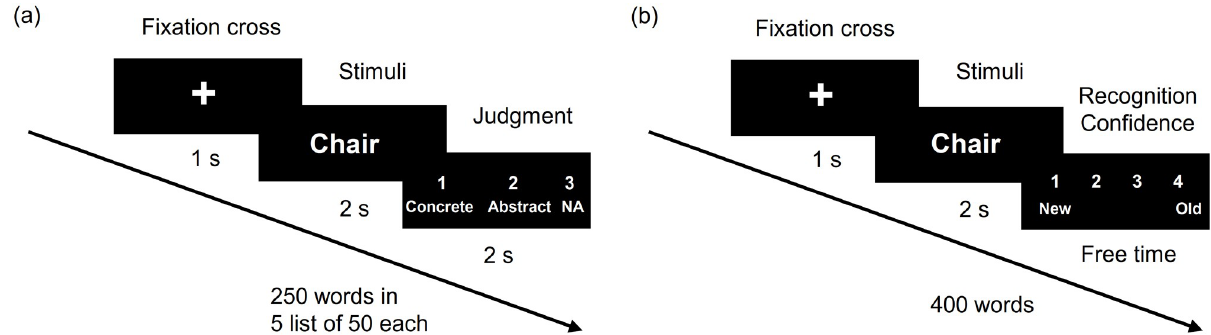
Fig 1. Experimental timeline of the declarative memory paradigm. (a) Encoding task: 250 words are presented in five lists of 50 words each. (b) Retrieval task: 400 words (250 old words and 150 new words) are presented. Participants have to select whether the presented stimulus is an old or new word, depending on the stimulus presented in the encoding task. These two tasks are separated by an arithmetic distraction task.